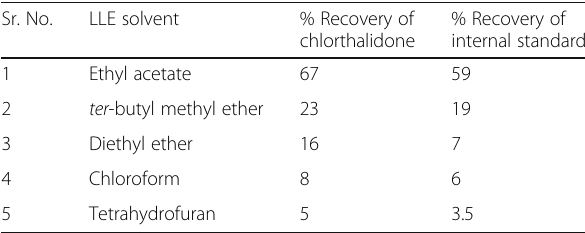
Table 1 % Recovery of chlorthalidone and internal standard in different LLE solvents Sr. No.